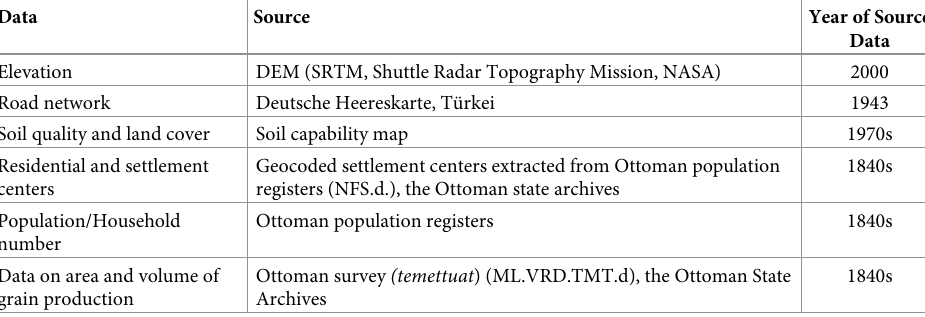
Table 2. Sources of data used in the